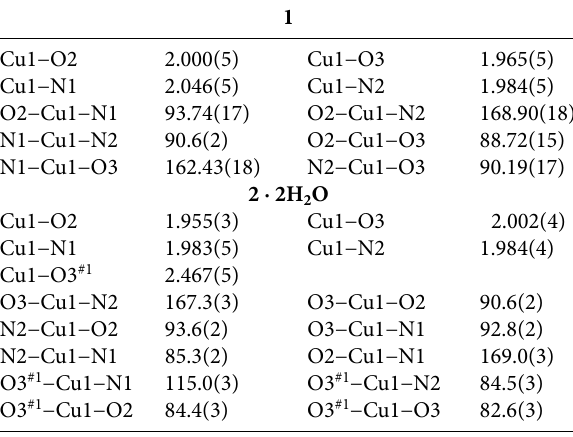
Table 2. Selected bond lengths (Å) and angles (°) for 1 and 2 · 2H 2 O